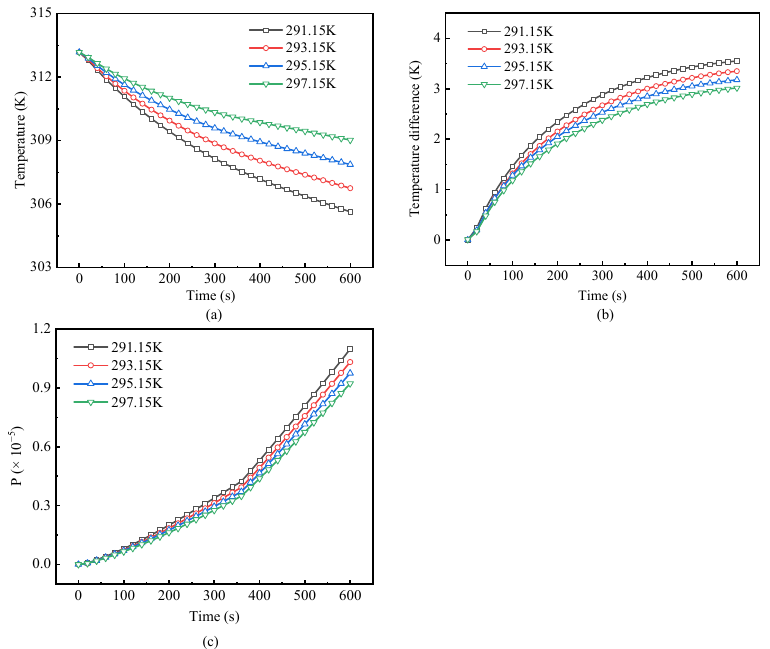
Figure 7. The effects of saturation temperature (a) Average temperature of the module; (b) Temperature uniformity of the module; (c) Battery consistency in the module.